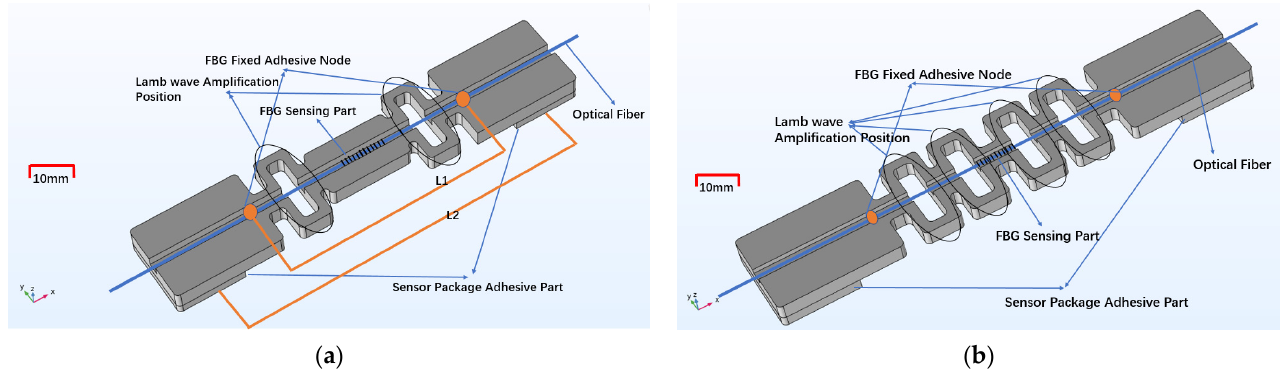
Figure 1. The loop-shape package structures. ( a ) Normal I-shaped FBG sensor model; ( b ) Improved I-shaped FBG sensor.